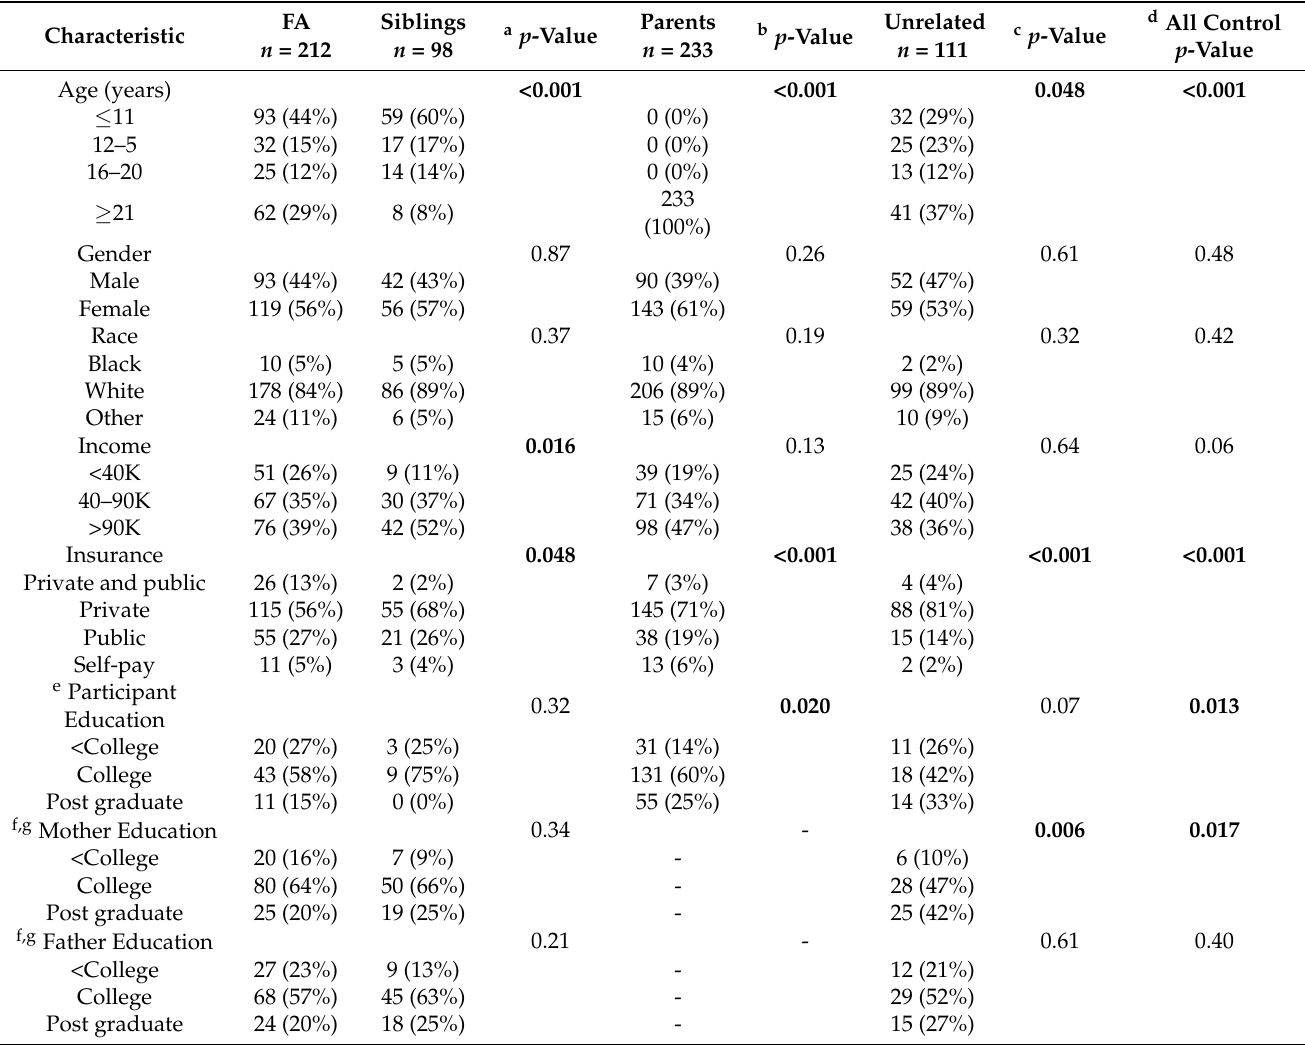
Table 1. Study Population